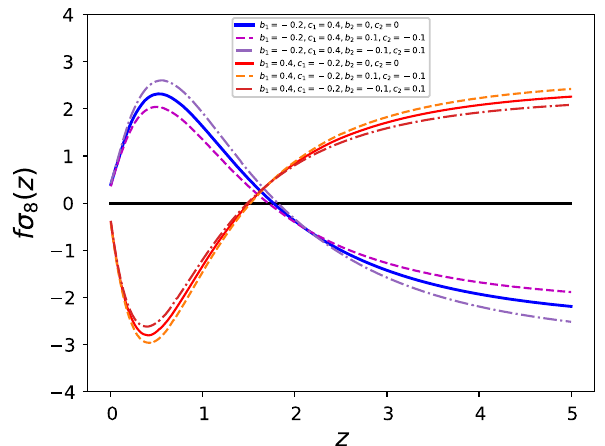
Fig. 2 The relative difference of growth rate as a function of redshift. The free parameters are the same as those of Fig. 1